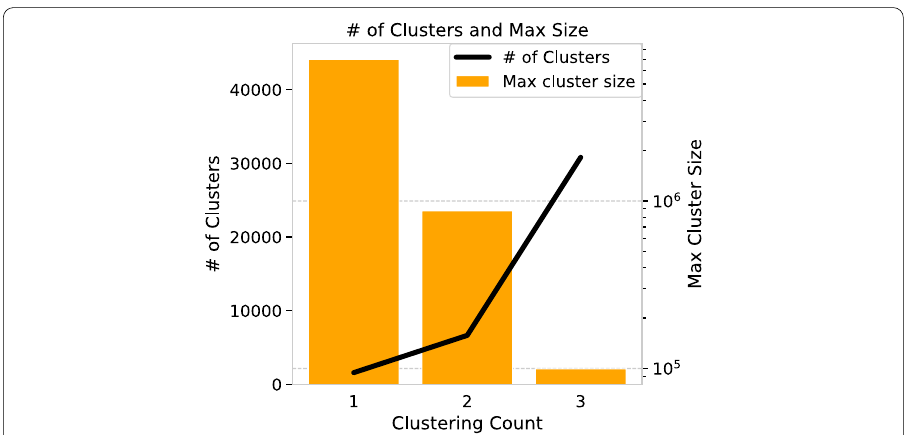
Fig. 7 Sensitivity of clustering in 2020. Every sub-clustering, the maximum size of cluster is reduced by about 1/10, and the number of clusters is increased nearly tenfold